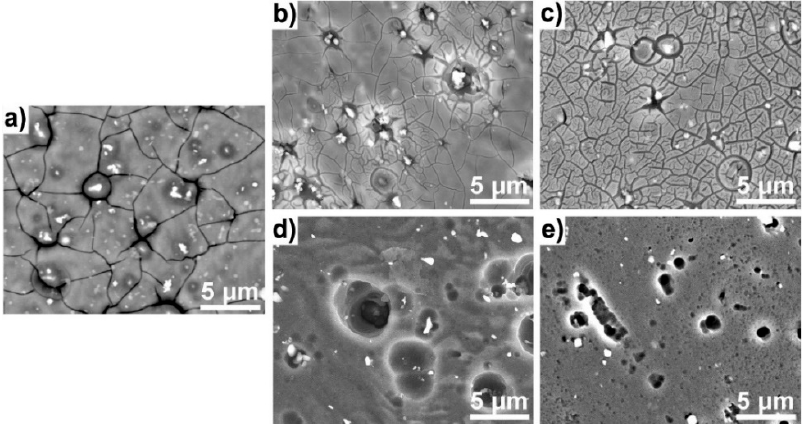
Figure 5. SEM micrographs of aluminum alloy 5754 surface exposed to bicarbonate buffer (pH = 11) for 24 h: ( a ) in absence of corrosion inhibitor; with addition of resorcinol at concentration ( b ) 10 mM and ( c ) 100 mM or with addition of catechol ( d ) 10 mM and ( e ) 100 mM.